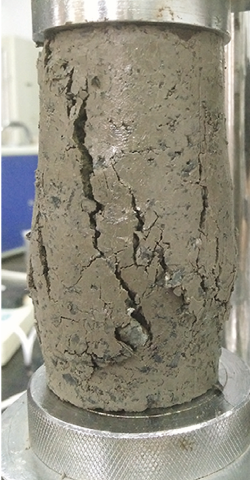
Figure 17: Bulging failure of mixture with C